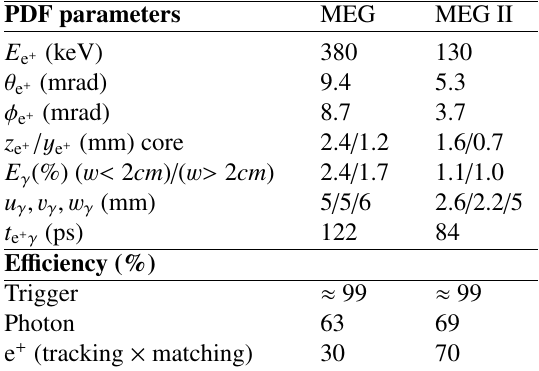
Table 1: Resolutions (Gaussian σ ) and e ffi ciencies of MEG II compared with those of MEG